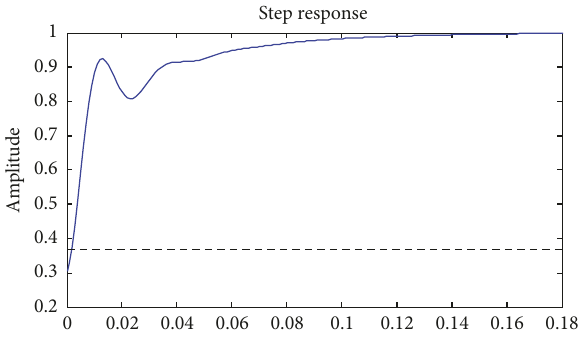
Figure 9: DC-DC boost converter Matlab/Simulink.